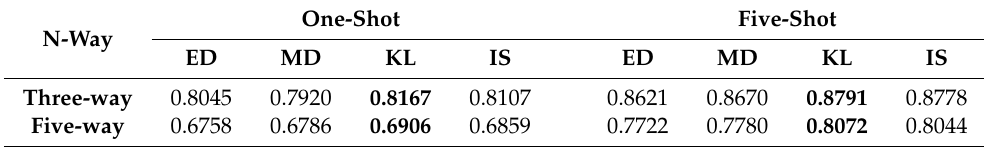
Table 4. Results for Experiment III: prototypical networks on early stage subset.